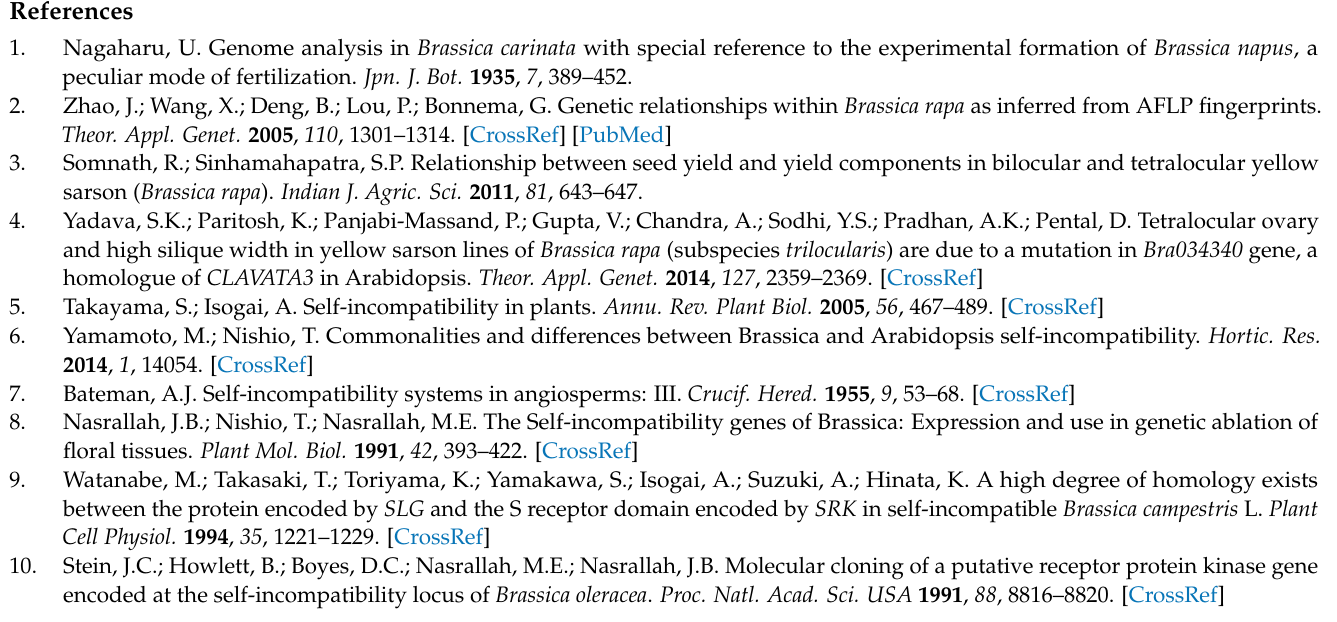
morphic markers; Table S1: Molecular markers designed for foreground selection of three targeted loci; Table S2: Self-compatibility primers designed based on the sequences of the SLG , SRK , and SP11 genes; Table S3: Background selection marker distribution on ten chromosomes of Brassica rapa